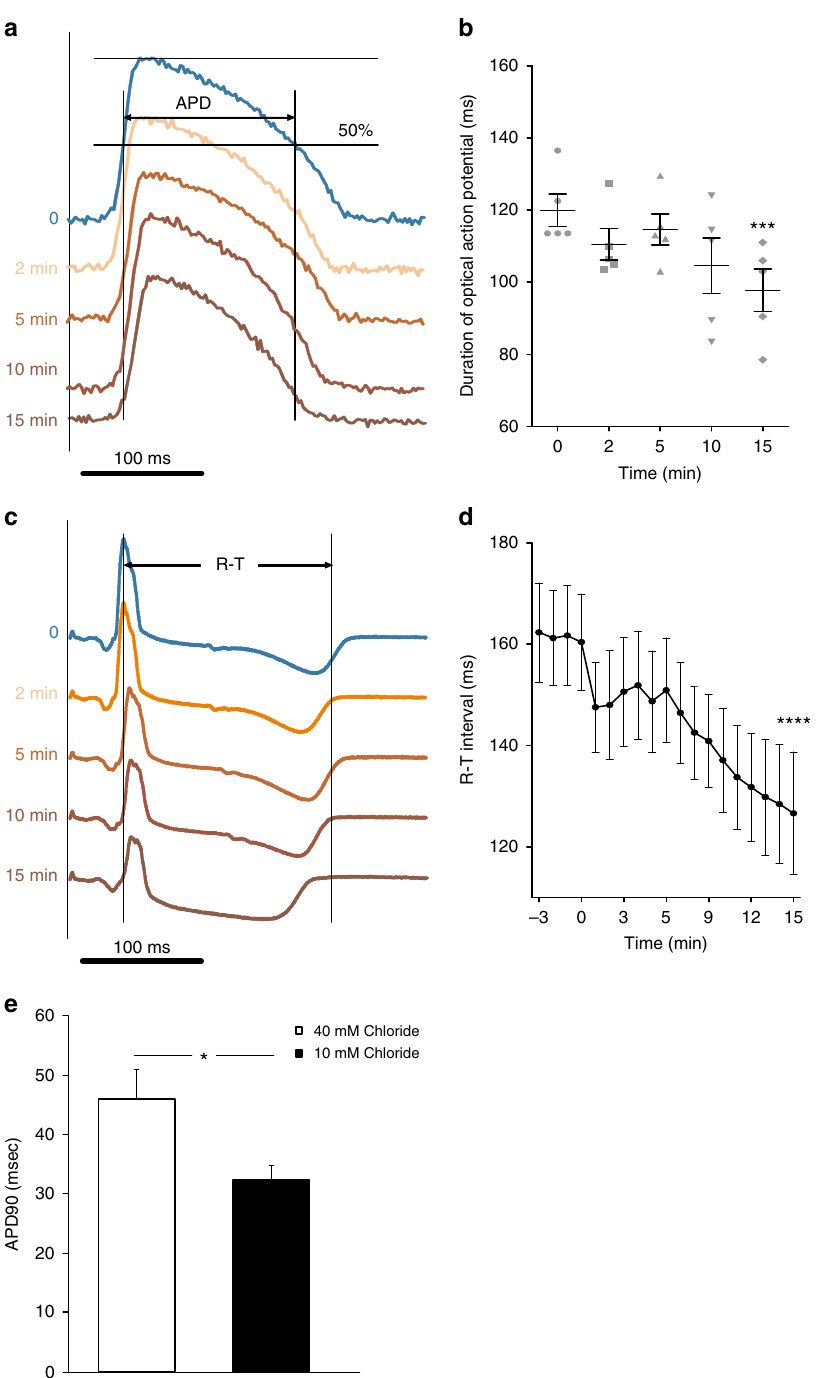
Fig. 4 Intracellular alkalization and low [Cl − ] i shortens the action potential duration and R-T interval. a Action potentials of rabbit hearts measured before and during application of 10 mM NH 4 Cl. APD: Action potential duration. b Mean APD during application of NH 4 Cl ( n = 5). Zero indicates time of intervention. c ECGs in rabbit hearts before and during application of 10 mM NH 4 Cl. d Mean RT interval in rabbit hearts ( n = 5). In a , c the records are aligned at the pacing stimulus. *** p < 0.001, **** p < 0.0001 as determined by one-way repeated measures ANOVA. Zero indicates time of intervention. e Bar graph showing APD90 of rat ventricular cardiomyocytes patched with 40 mM (open, n = 23) or 10 mM (black, n = 16) chloride in the pipette solution. * p < 0.05 as determined by one-way repeated measures ANOVA. Error bars throughout represent the